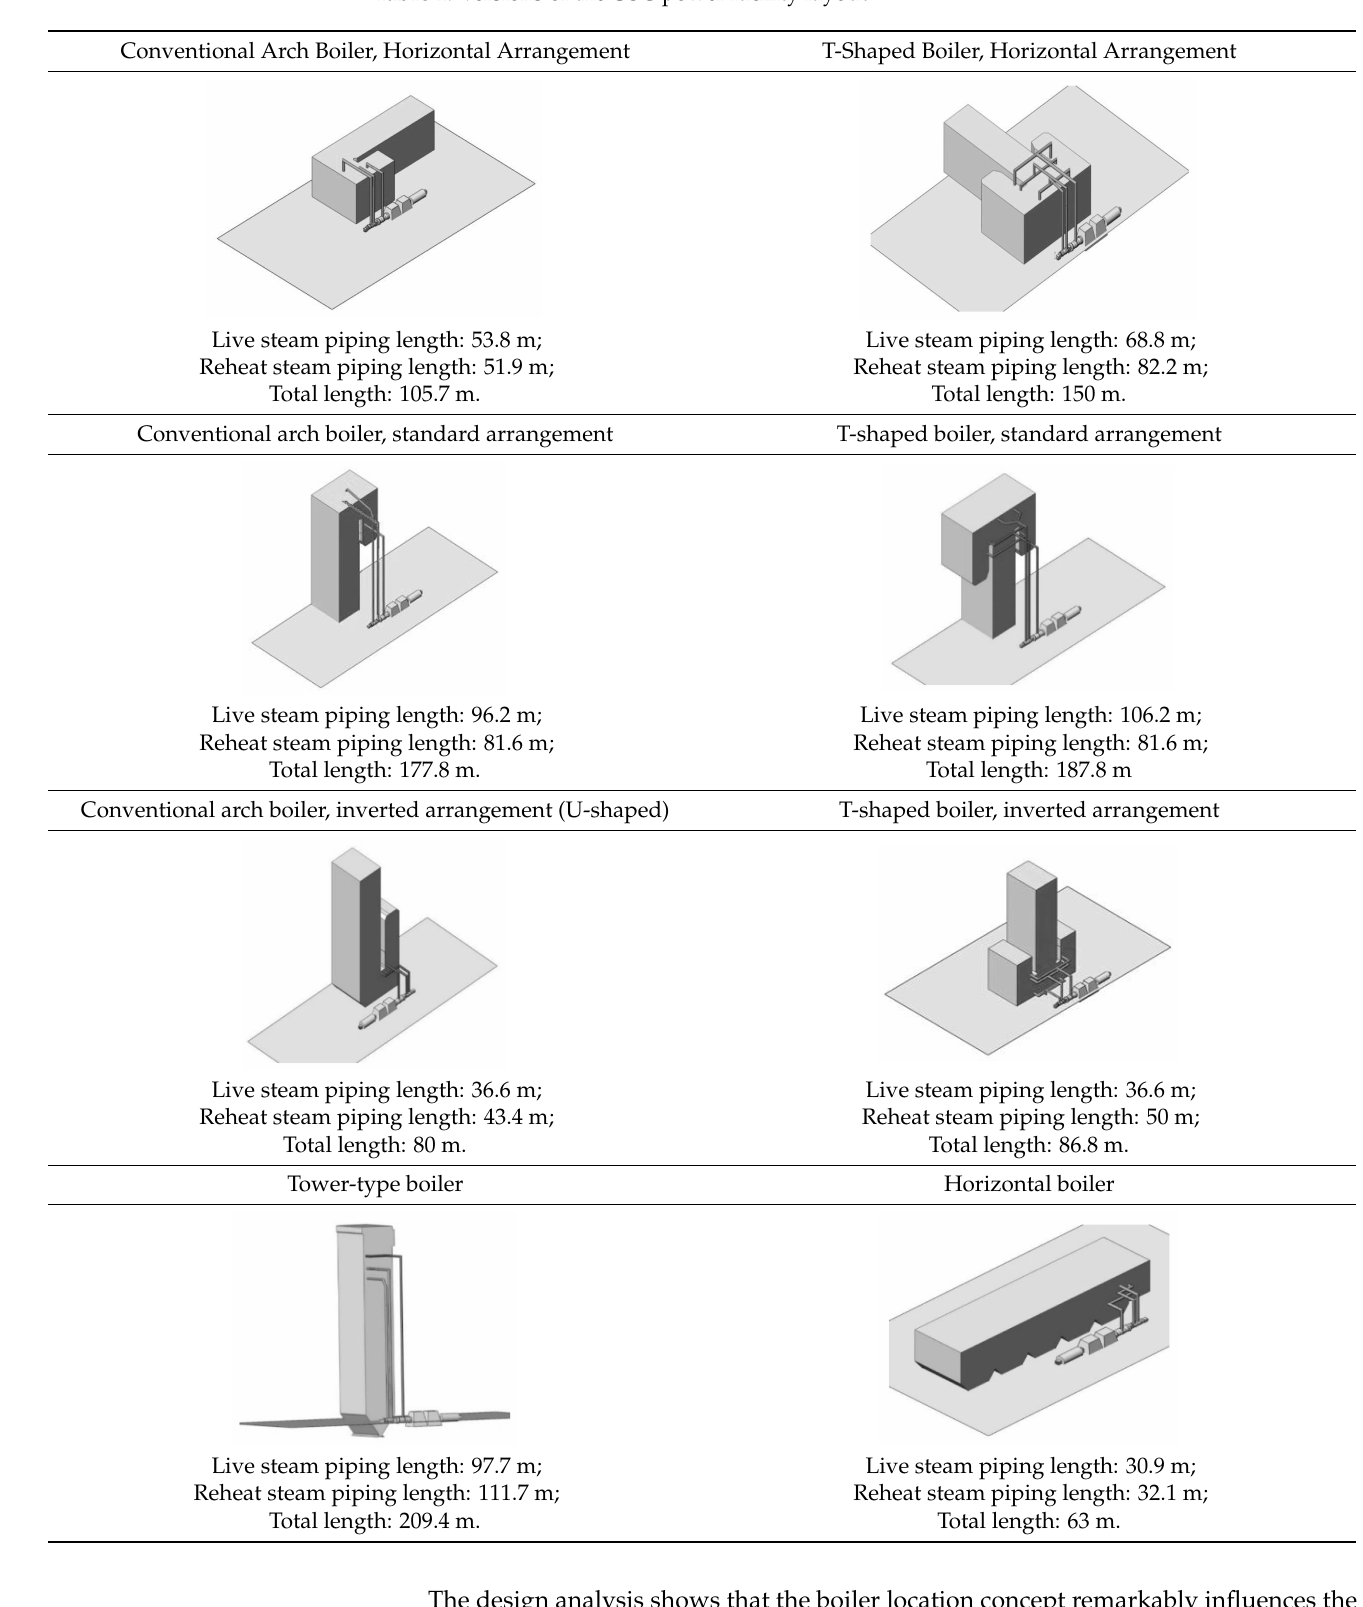
Table 1. Versions of the USC power facility